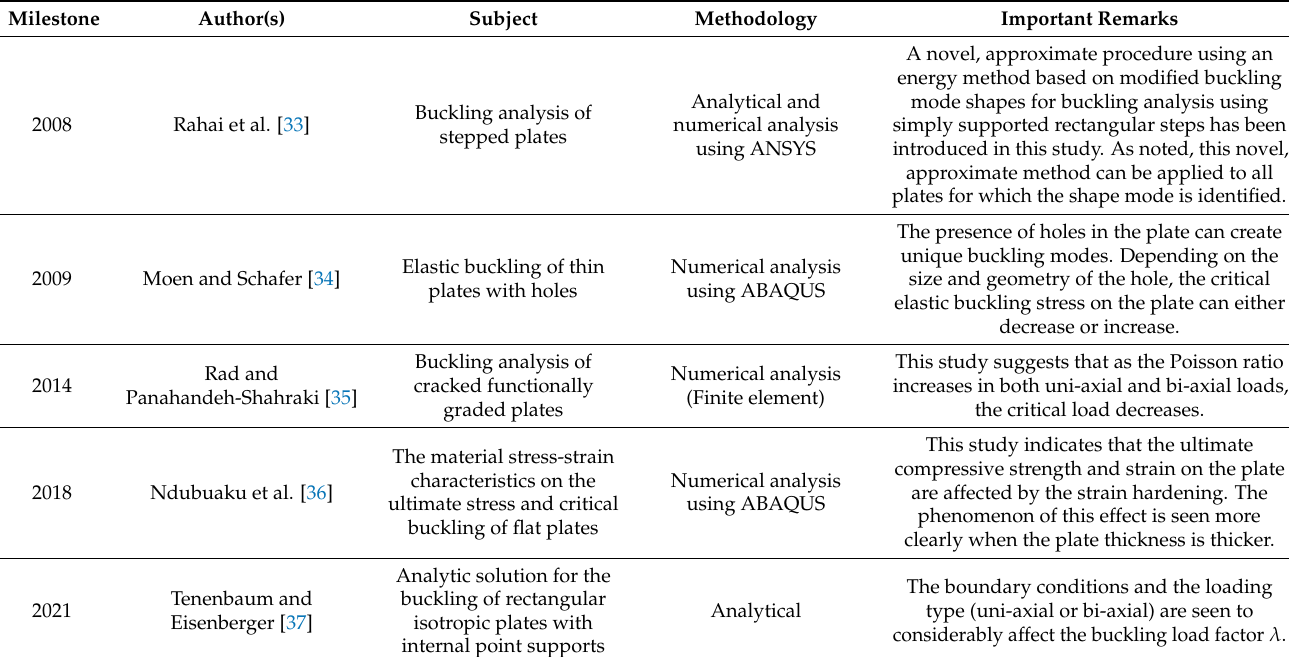
Table 2. Milestone research on the plate buckling.